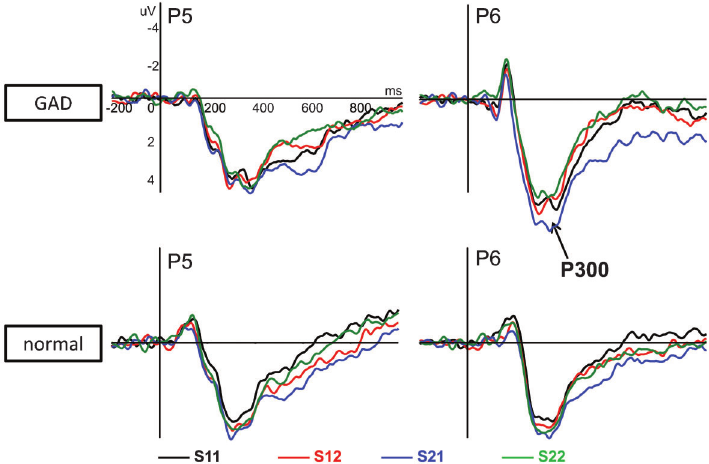
Figure 4. Event-related potentials recorded for patients with generalized anxiety disorder (GAD) and normal controls under S negative/negative , S negative/neutral , S neutral/negative and S neutral/neutral conditions, showing P300 amplitude at the site of P5 and P6.